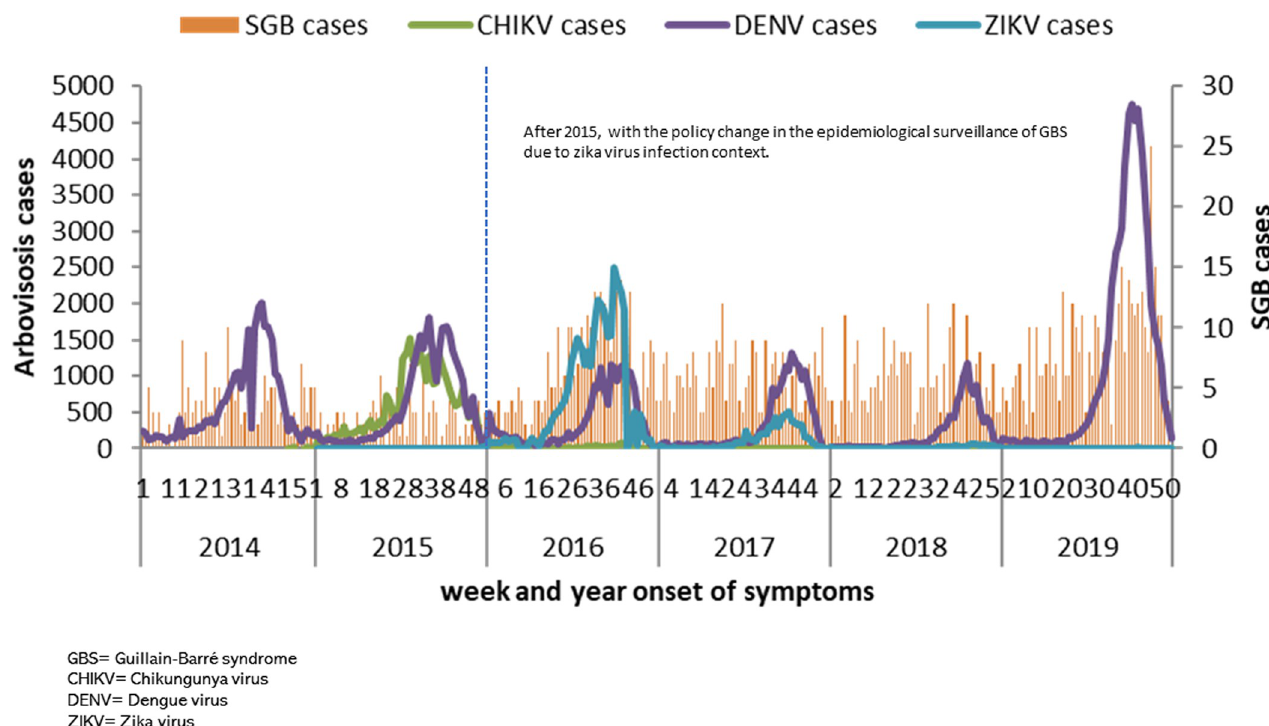
Fig 1. Epidemic curve of GBS and arbovirus cases in Mexico, IMSS 2014–2019.